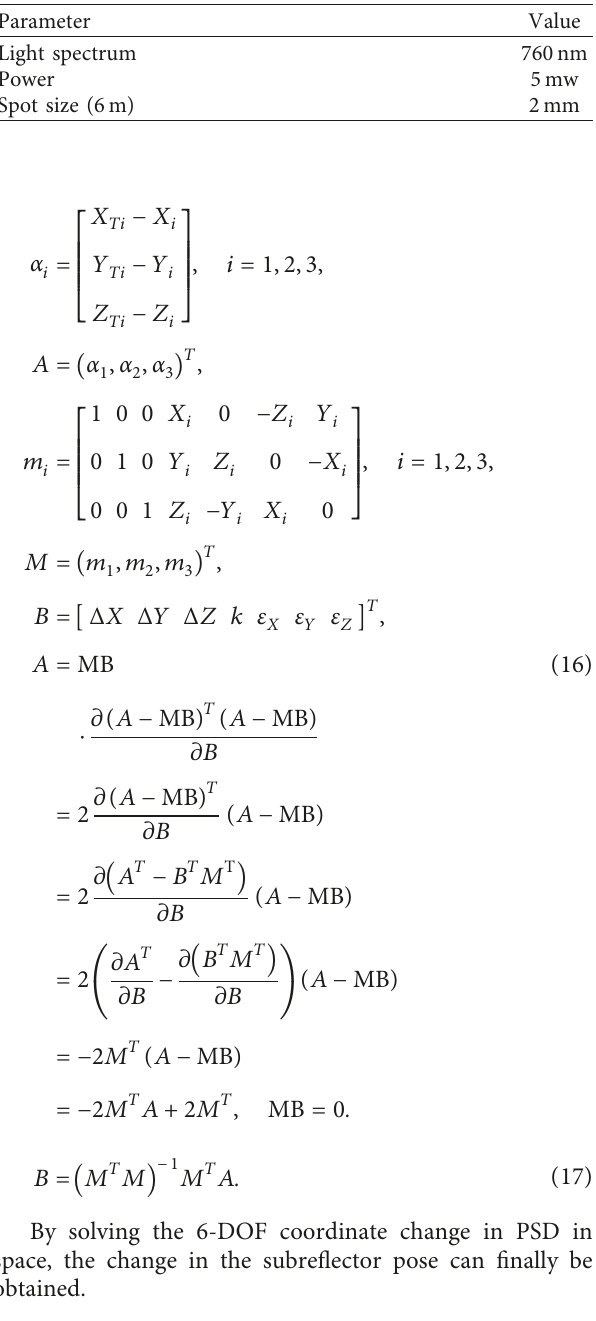
Table 5: Laser module